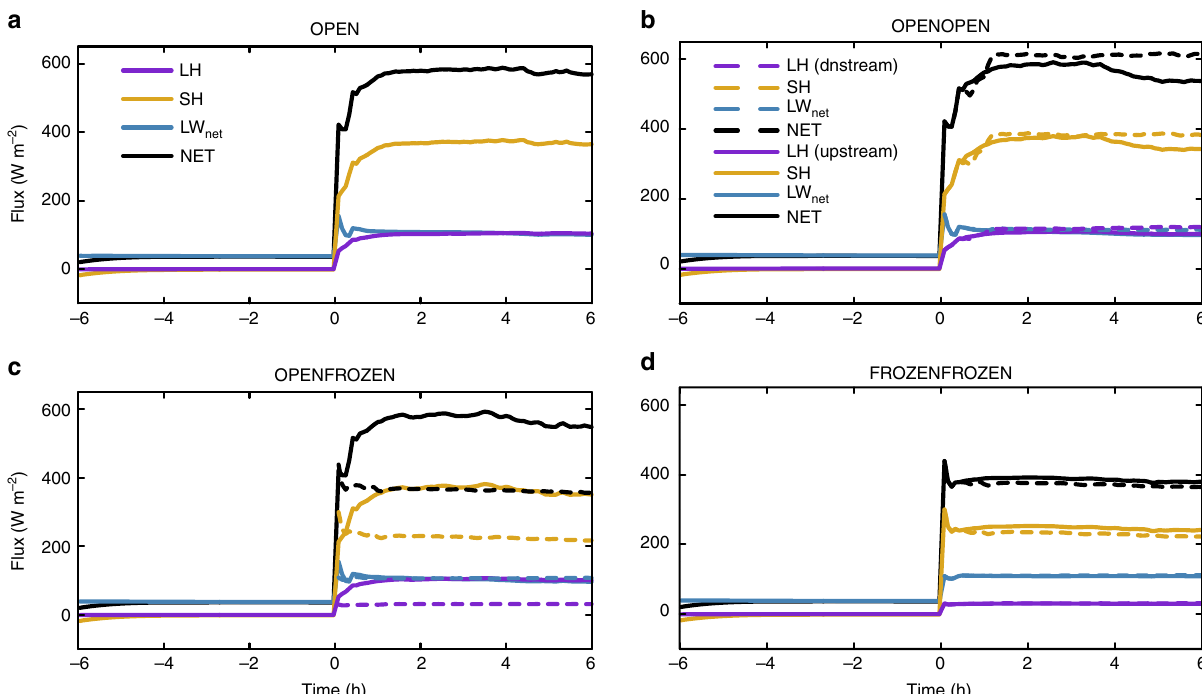
Fig. 5 Time series of the surface fl uxes averaged over lead area. a Time series of surface latent heat fl ux (LH), sensible heat fl ux (SH), net longwave radiative fl ux (LW net ), and the net total fl ux (NET) averaged over the lead area from the OPEN case. NET excludes conductive heat fl ux at the top layer, and upward fl ux is de fi ned as positive. b The same as a but for the OPENOPEN case. Solid curves indicate the fl uxes averaged over the upstream open lead while dashed lines indicate the fl uxes averaged over the downstream open lead. c The same as b but for the OPENFROZEN case with an upstream open lead (solid lines) and a downstream frozen lead (dashed lines). d The same as b but for the FROZENFROZEN case.